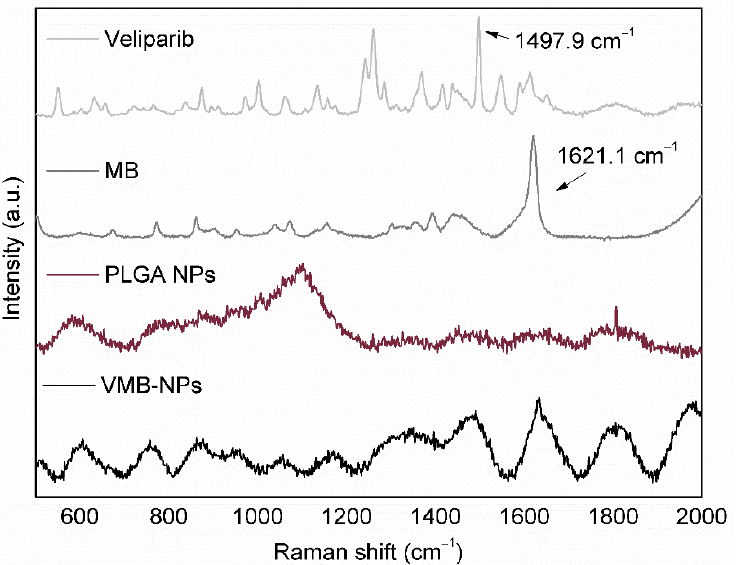
Figure 4. RAMAN spectra of NPs suspensions (PLGA NPs and VMB-NPs), and MB and veliparib powders.